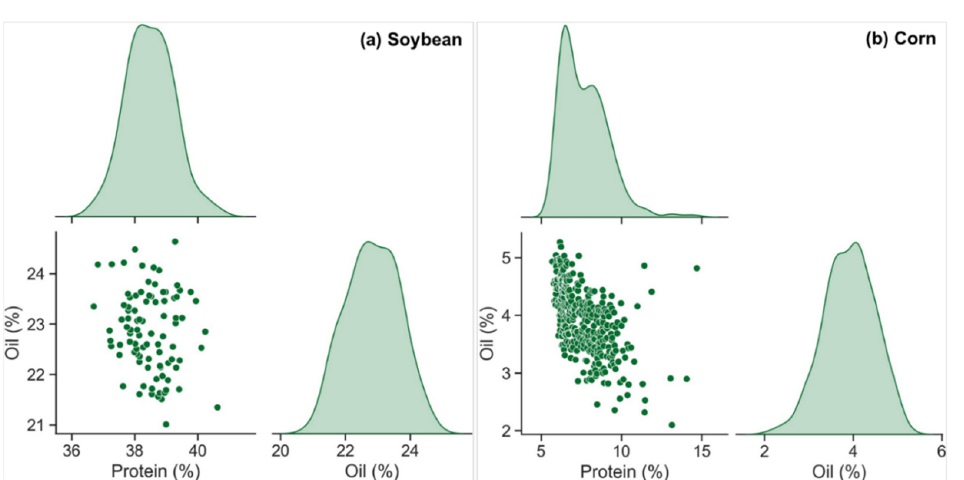
Table 2. Hyperspectral and LiDAR sensors used in this study. Sensor Vender/Brand Recorded Info. Headwall Hyperspectral